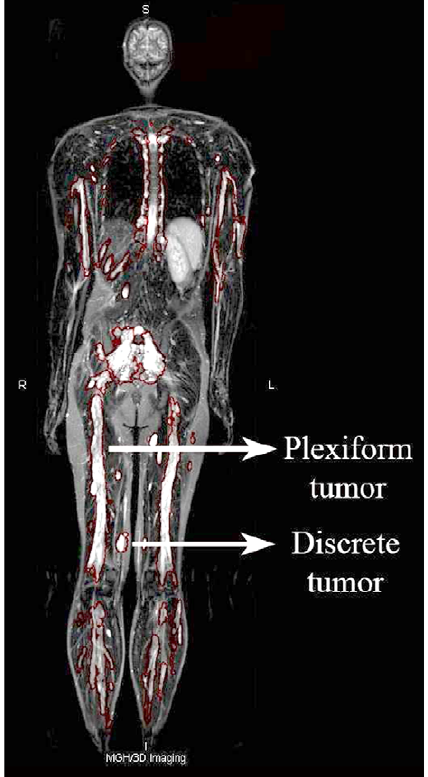
Figure 1. Appearance of internal nerve sheath tumors on Whole-Body MRI. Tumor type was defined according to the radiologic appearance without need for pathological diagnosis. Tumors that were locally circumscribed on MRI scan were classified as circumscribed tumors and those that were invasive or involved multiple nerves were classified as plexiform